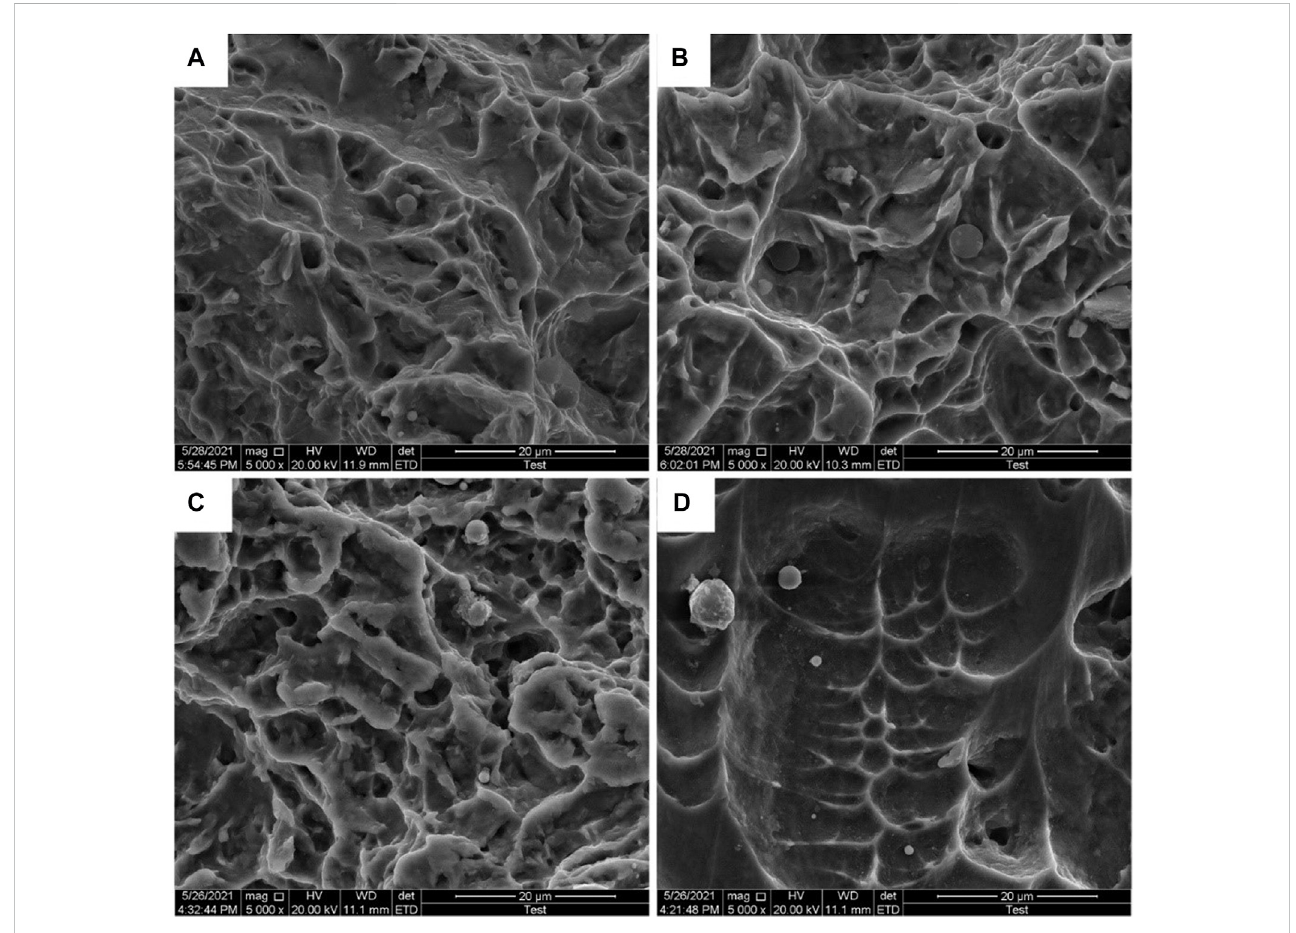
FIGURE 11 The SEM fractographies (5,000×): (A) smooth round bar, (B) notched round bar, R = 10 mm, (C) notched round bar, R = 5 mm, (D) shear-induced specimen.